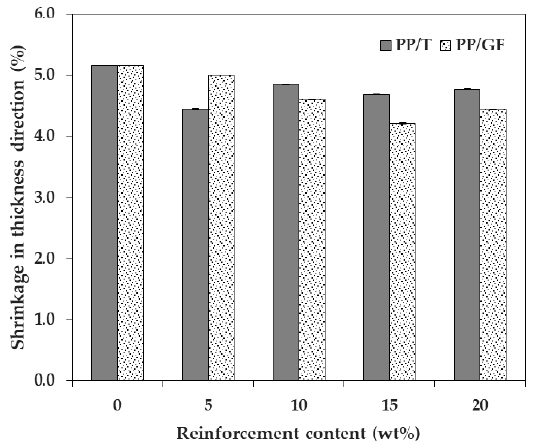
Figure 4. Shrinkage of PP/T and PP/GF in the thickness direction, depending on reinforcement type.